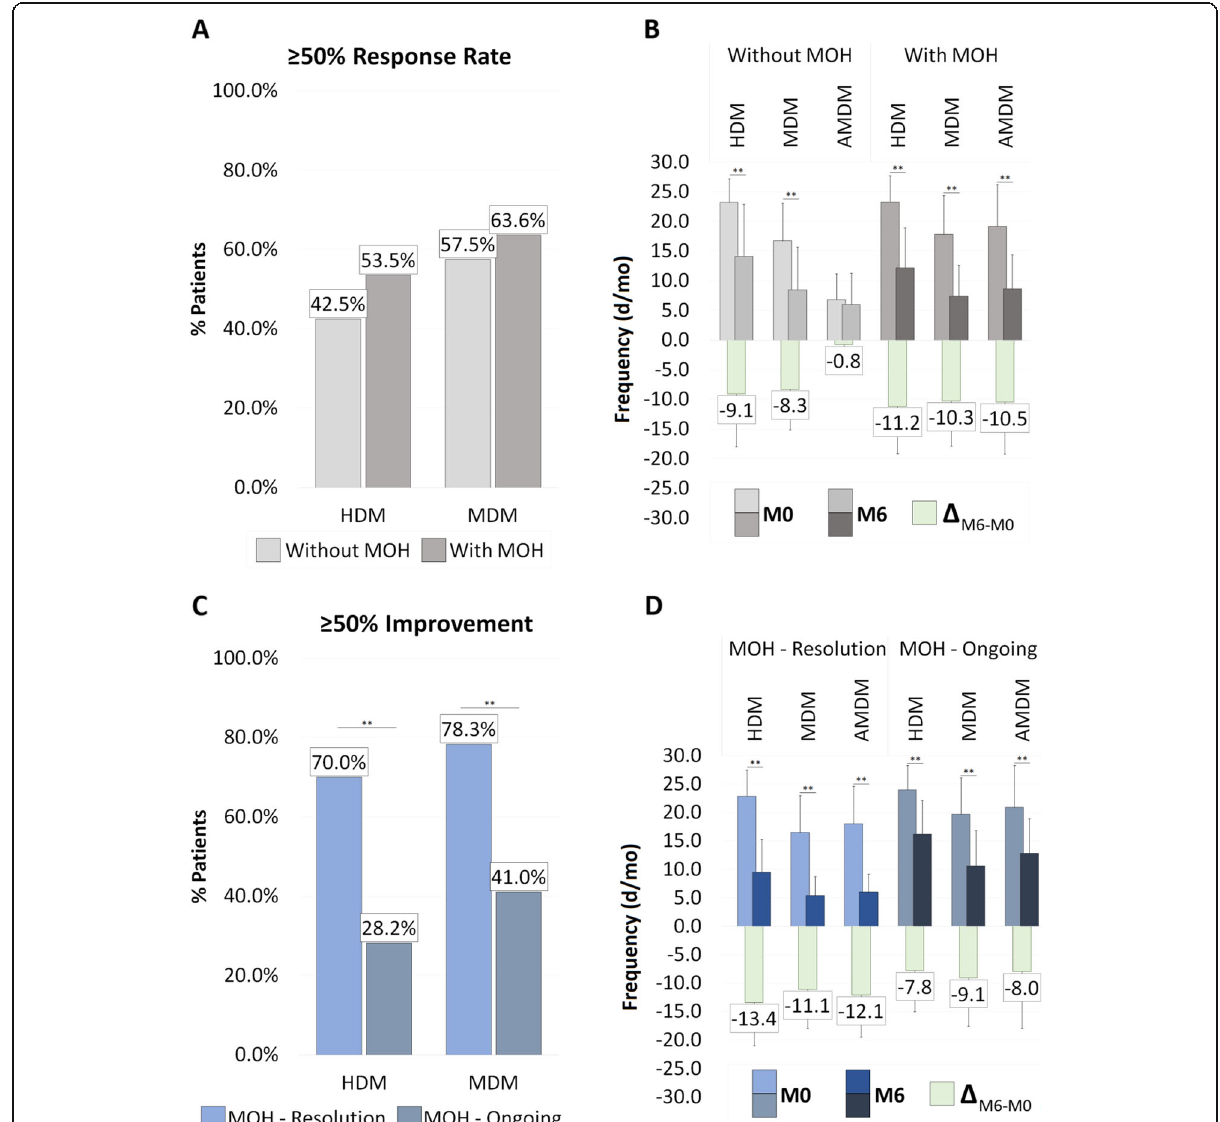
Fig. 1 Anti-CGRP MAbs ≥ 50% RR ( A; C ) and mean change in primary outcomes after 6 months of treatment ( B; D ) in study patients. In section A, we report ≥ 50% RR in HDM and MDM in CM patients with MO (light gray, 99/139) and without MO (dark gray, 40/139) at baseline. In section C, we also report ≥ 50% RR in patients with basal MO (99/139), comparing them according to their MO response after 6 months of treatment: MO resolution (light blue, 60/99) vs. MO ongoing (dark blue, 39/99). In section B, we report the mean change in HDM, MDM and AMDM after 6 months of treatment in CM patients with MO (light gray, 99/139) and without MO (dark gray, 40/139) at baseline. In section D, we also report the mean change in HDM, MDM and AMDM in patients with basal MO (99/139), comparing them according to their MO response after 6 months of treatment: MO resolution (light blue, 60/99) vs. MO ongoing (dark blue, 39/99). In green is shown the mean difference between Month 0 and Month 6 ( Δ ). ** P -value < 0.01 (AB: Significance assessed with Fisher ’ s exact test; CD: Significance assessed with paired t-test). RR: Response